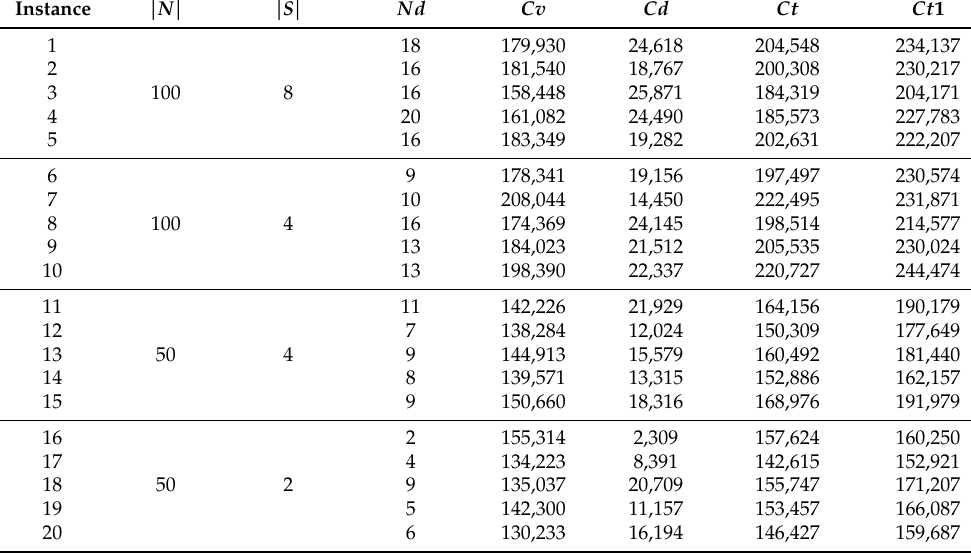
Table 6. Additional insights: the role of | S | .